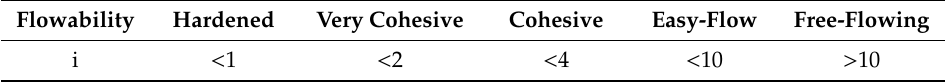
Table 2. Jenike flow index (i)